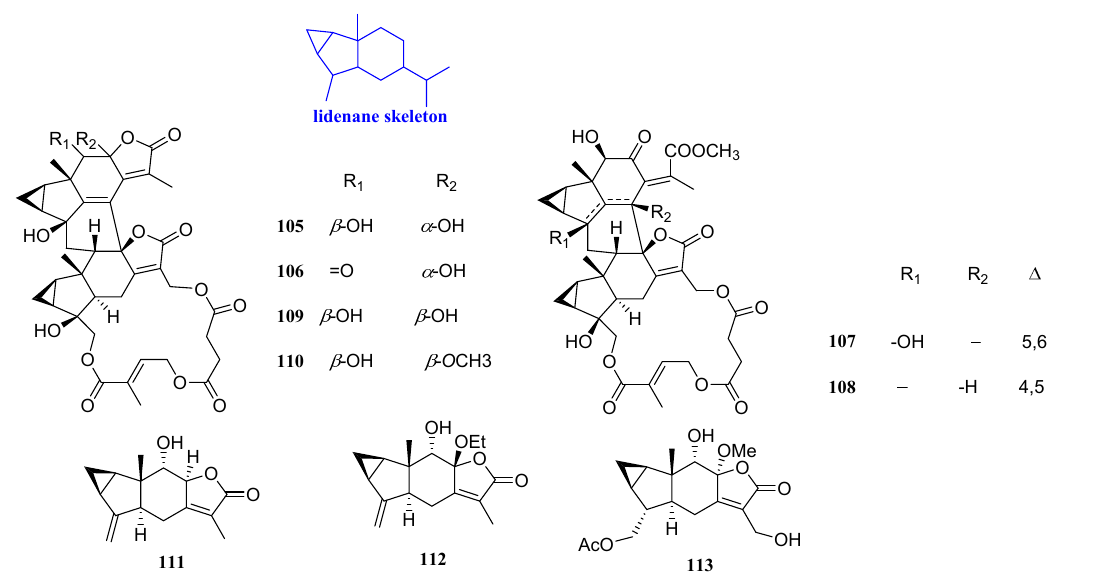
Figure 8. Structures of lindenane-type sesquiterpenoids 105 – 113 .